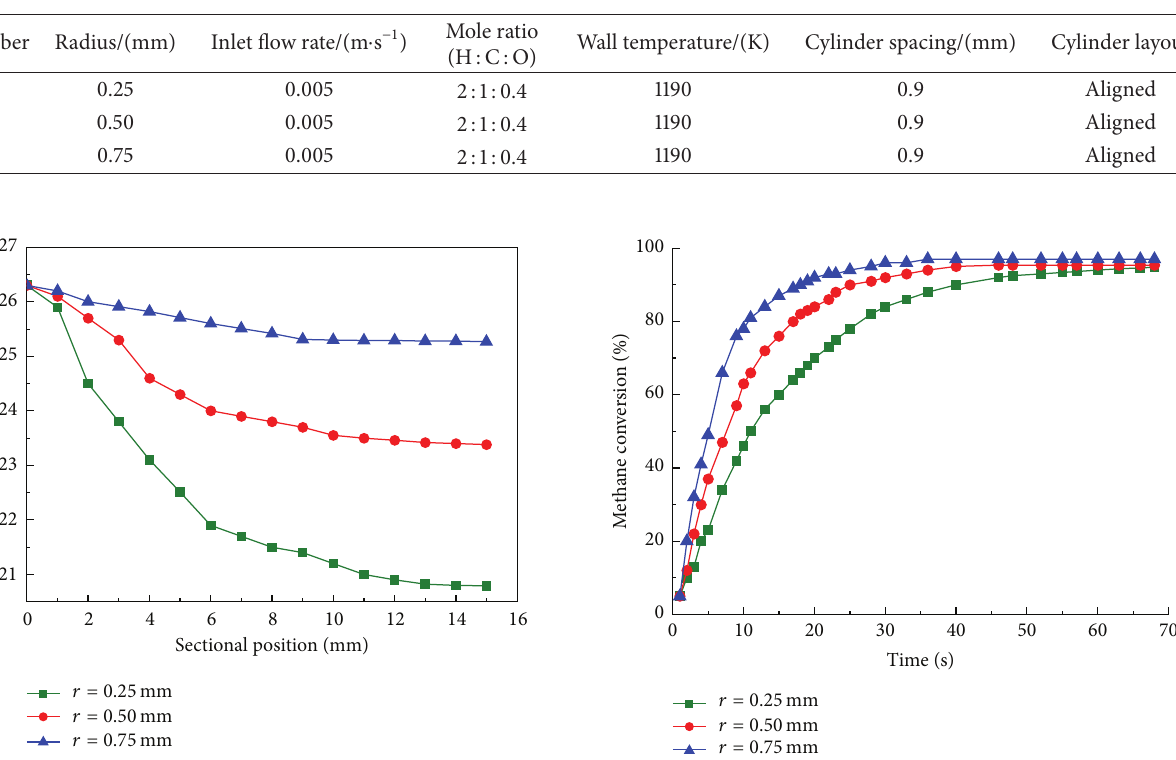
Table 3: Operating parameters with different cylinder radius.